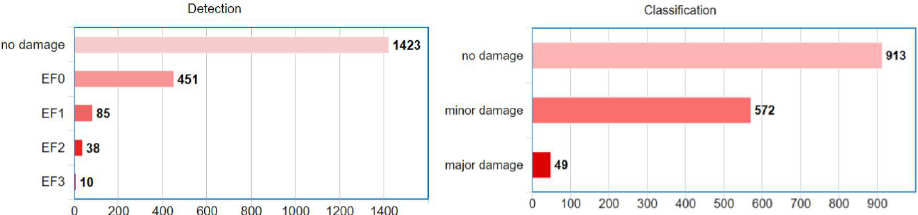
Figure 4. Annotation data size summary. For object detection ( left ), the unit is object number; for image classification, the unit is image